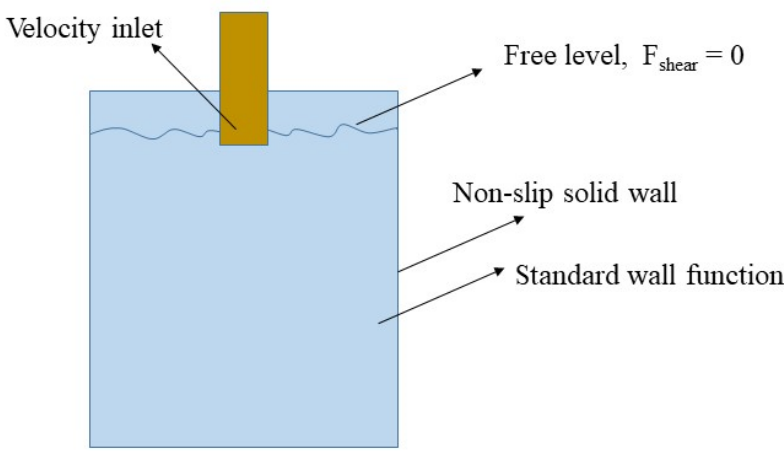
Figure 3. Schematic diagram of boundary condition. The equations were solved using the commercial software FLUENT. The QUICK scheme was adopted for the convection term, and the SIMPLEC algorithm was used to treat the pressure terms in the momentum equations. Table 1 shows the grid sensitivity. For this model, when the grid node was greater than 450,000, the deviation of maximum free-surface turbulent kinetic energy was very small. It can be regarded that the number of grids has no impact on the simulation results.